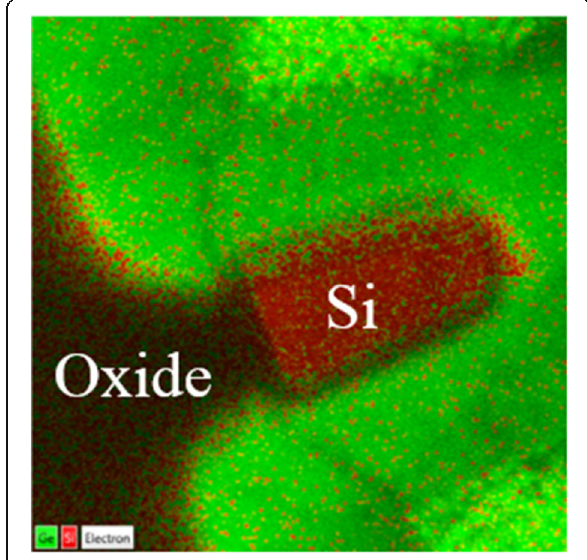
Fig. 11 TEM mapping for the channel structure that undergoes an over-etching